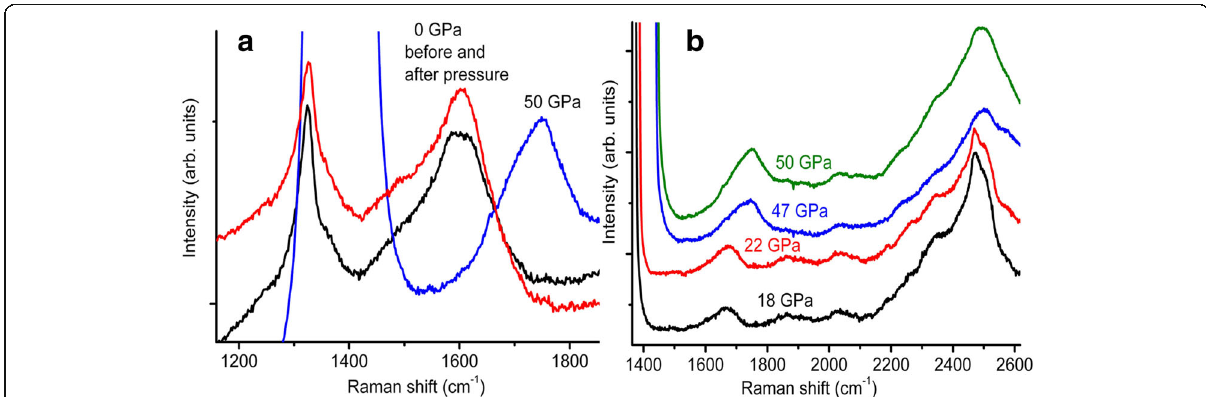
Fig. 5 a Raman spectra of the 2 – 5-nm nanodiamond-NaCl nanocomposite before and after pressure treatment and at a 50 GPa pressure. Excitation wavelength is 458 nm. The absence of the band with ω 0 = 1325 cm − 1 under pressure of 50 GPa is possible only for a case when the bulk modulus of the 2 – 5-nm nanodiamond exceeds 524 GPa. ( b ) Pressure induced shift of the 1600 cm − 1 Raman band; one halfwidth and intensity do not change under